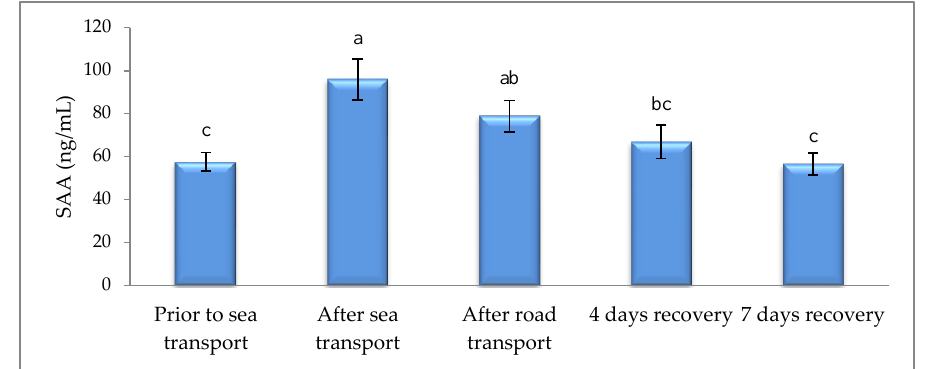
Figure 3. Effects of sea and road transport on serum amyloid-A (SAA) levels in cattle. The number of